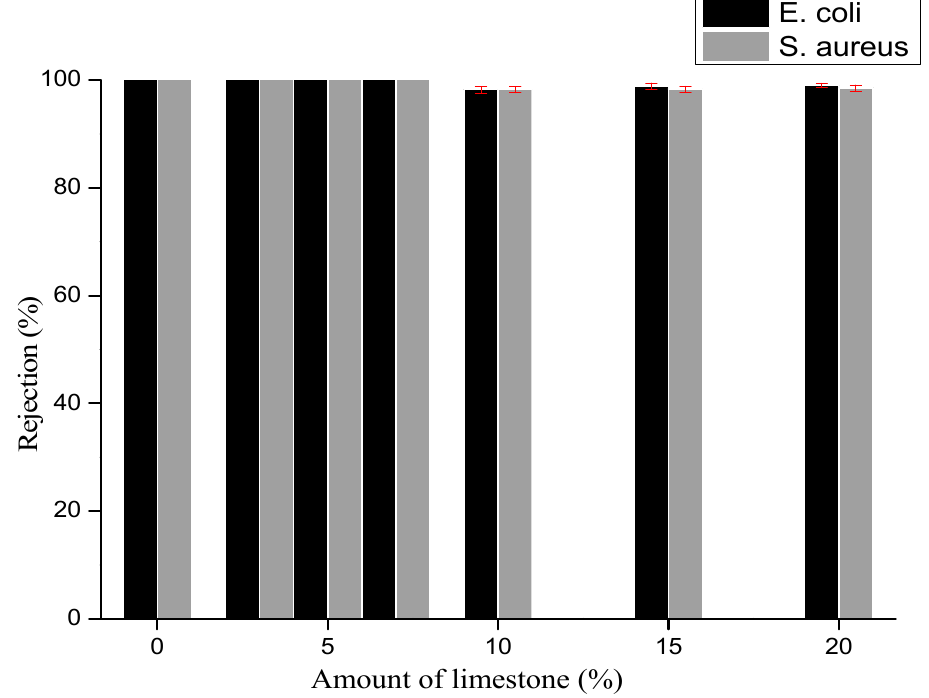
Figure 7. Bacteria rejection by the various membranes.